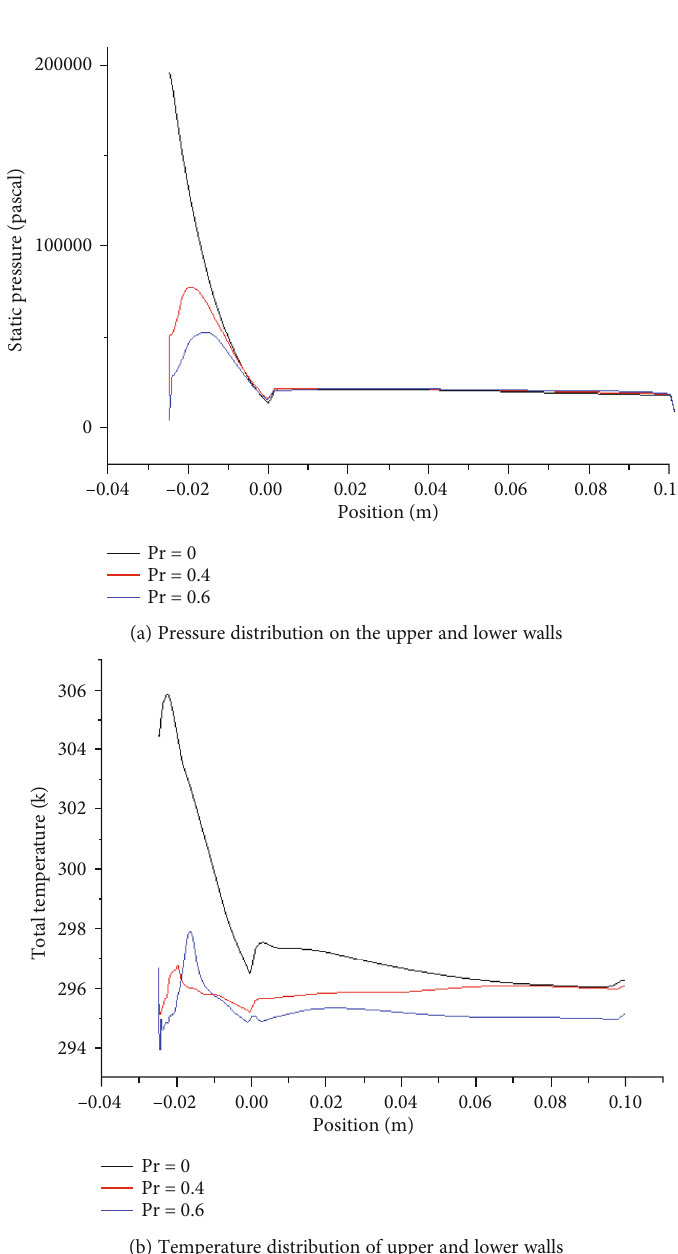
Figure 9: Pressure and temperature distribution on the wall surface of the ball